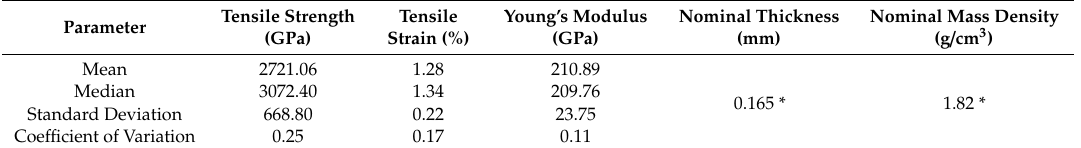
Table 1. Carbon Fiber-Reinforced Polymer (CFRP) characteristics.